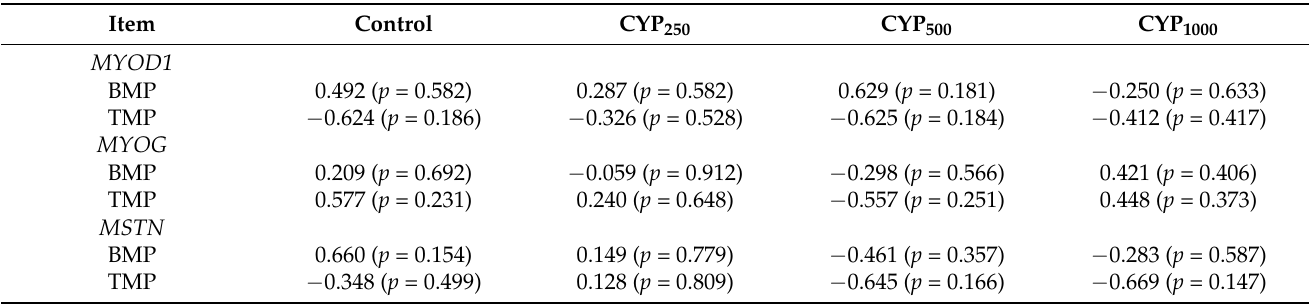
Table 3. The correlation between MYOD1 , MYOG , and MSTN mRNA expression of breast muscle and BMP or TMP.